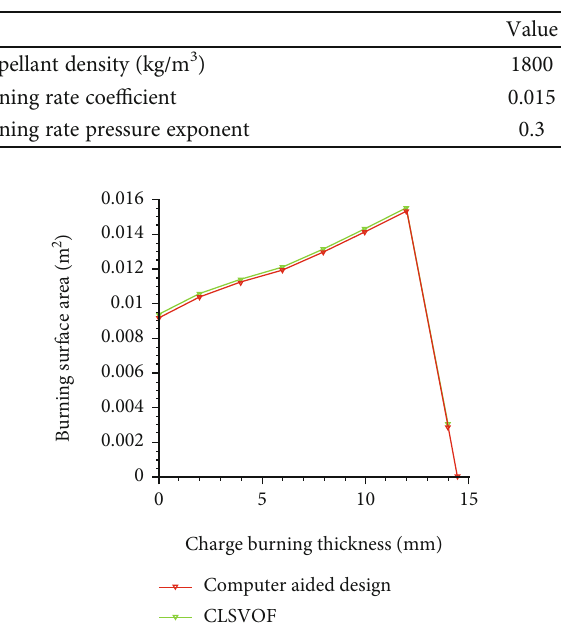
Table 2: Propellant parameters.